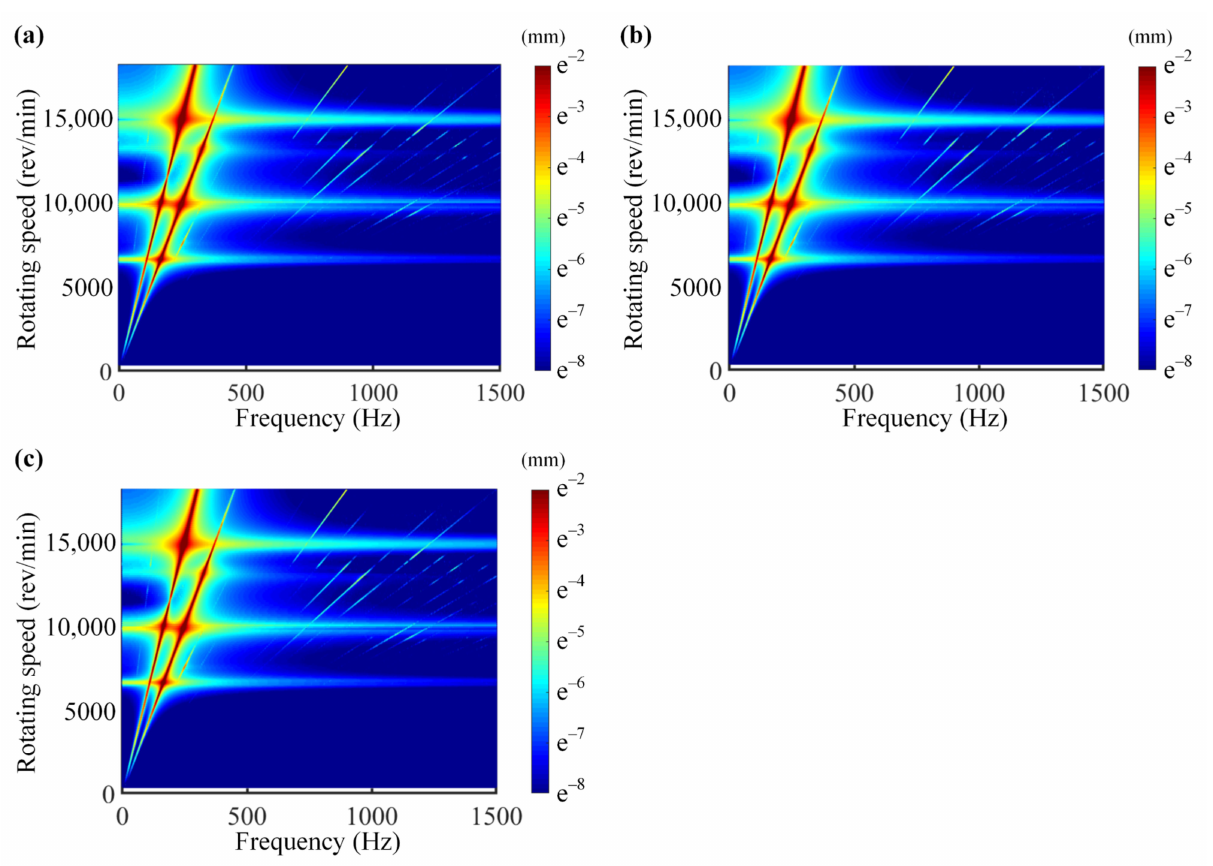
Figure 5. Spectrum cascades: ( a ) 24 elements; ( b ) 36 elements; ( c ) 48